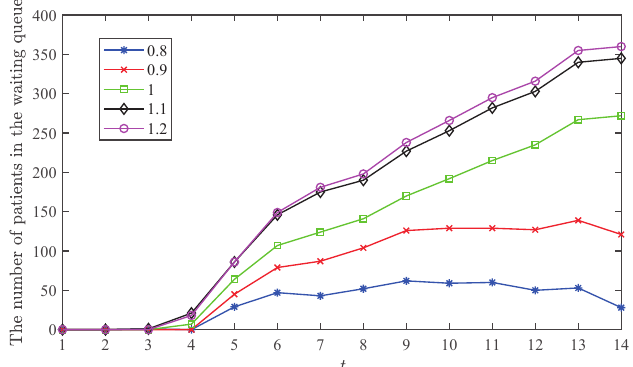
Figure 13. The number of patients in the waiting queue in case 2.